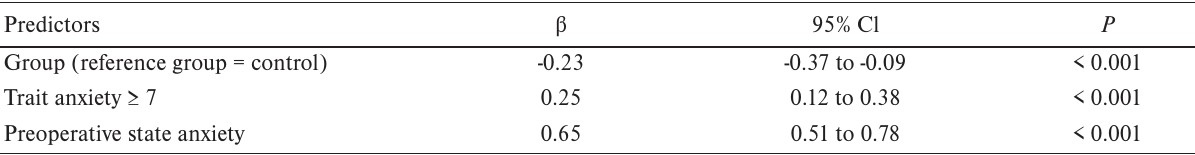
Table 3. Multivariate linear regression analyses predicting postoperative